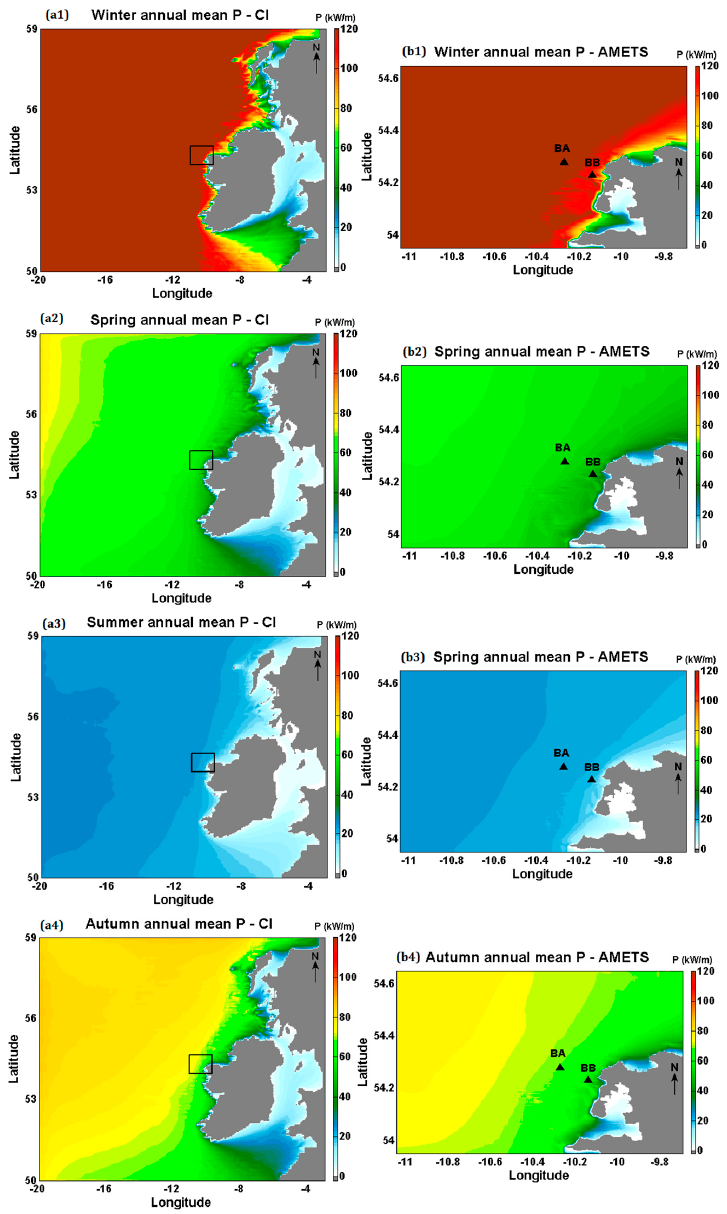
Figure 18. 12-year seasonal means of P (kW/m) for ( a1 – a4 ) CI model and ( b1 – b4 ) AMETS model.